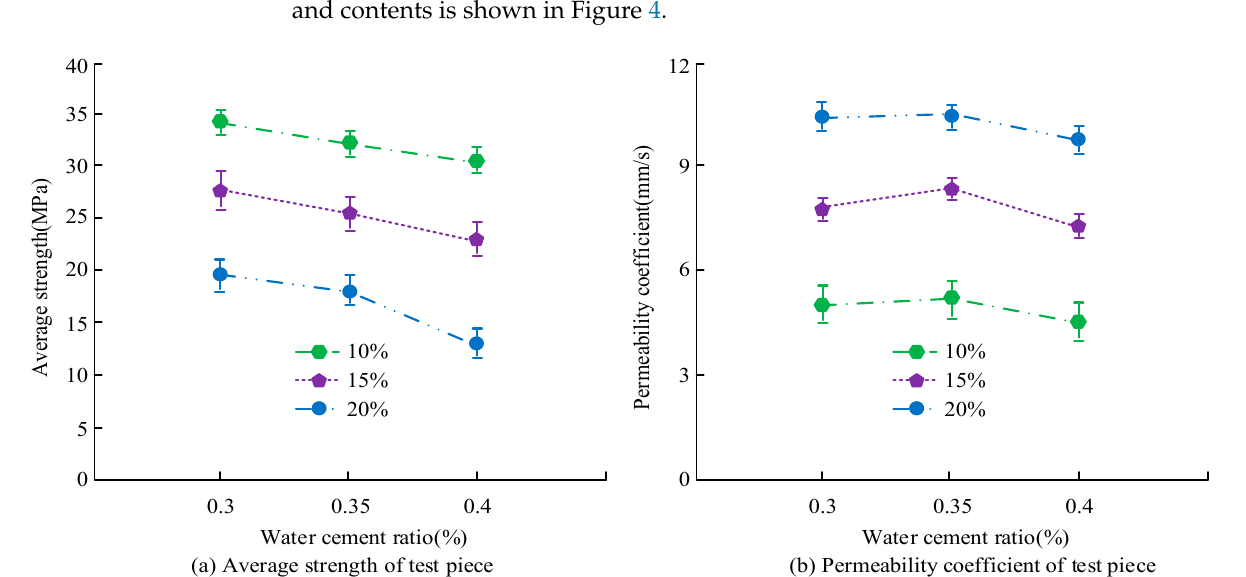
Figure 3. Performance comparison of test pieces under different water cementation ratio. ( a ) Aver- age strength of test piece; ( b ) Permeability coefficient of test piece.